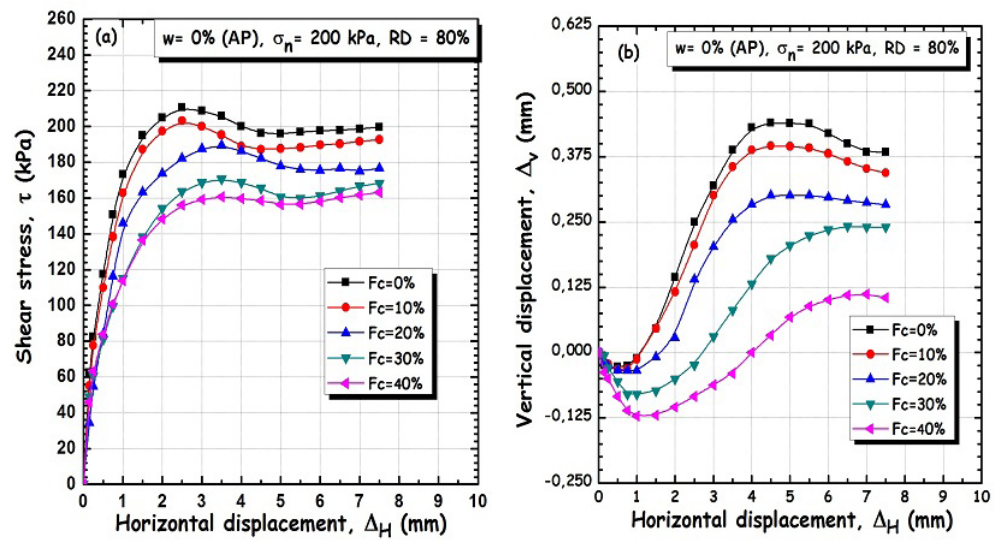
= 200 kPa): (a) variation of the shear n